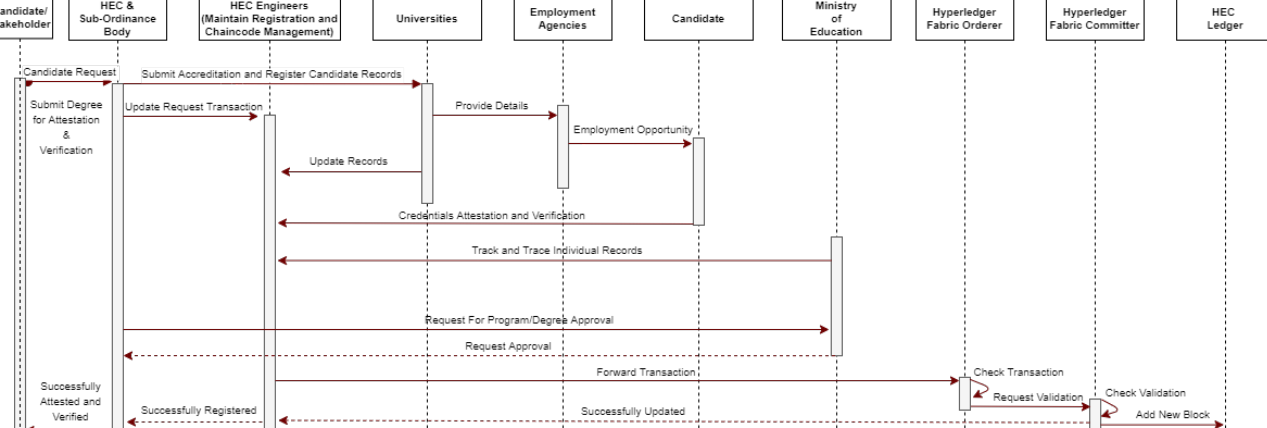
Figure 6. Sequence diagram of degree attestation and credentials verification, and validation of registration of node transaction processes.